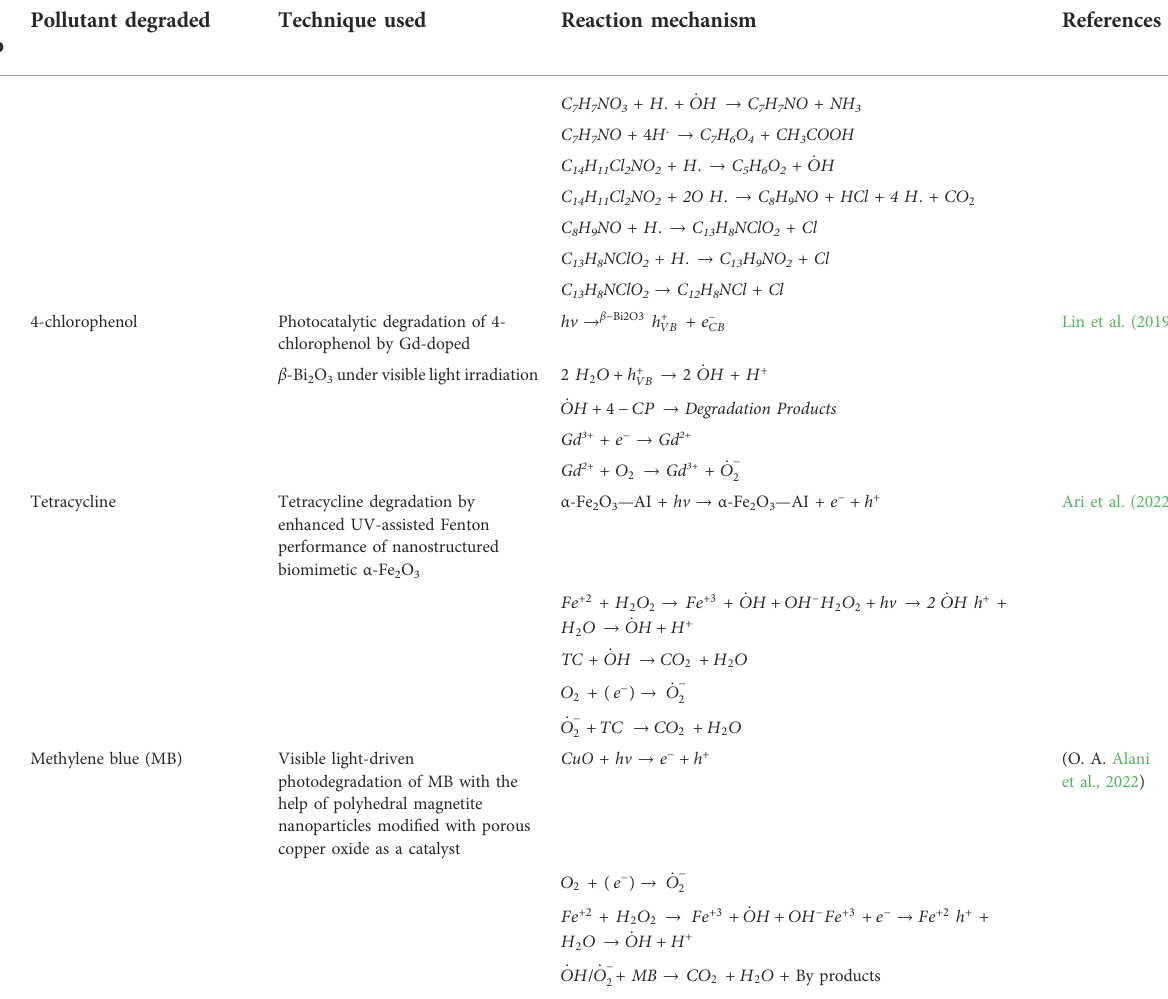
photocatalysis is an emerging method of photocatalysis.